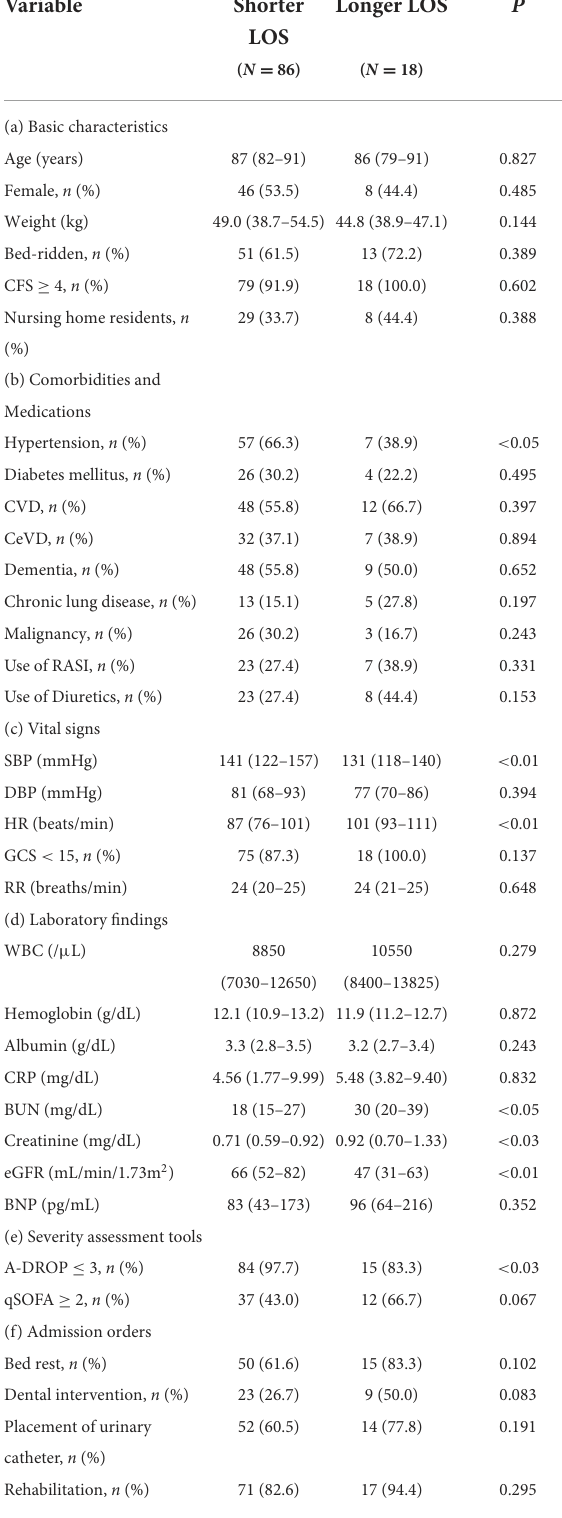
TABLE 1 Comparison of basic and characteristics between the two groups with different length of hospitalization; data are shown as n (%) or median (interquartile